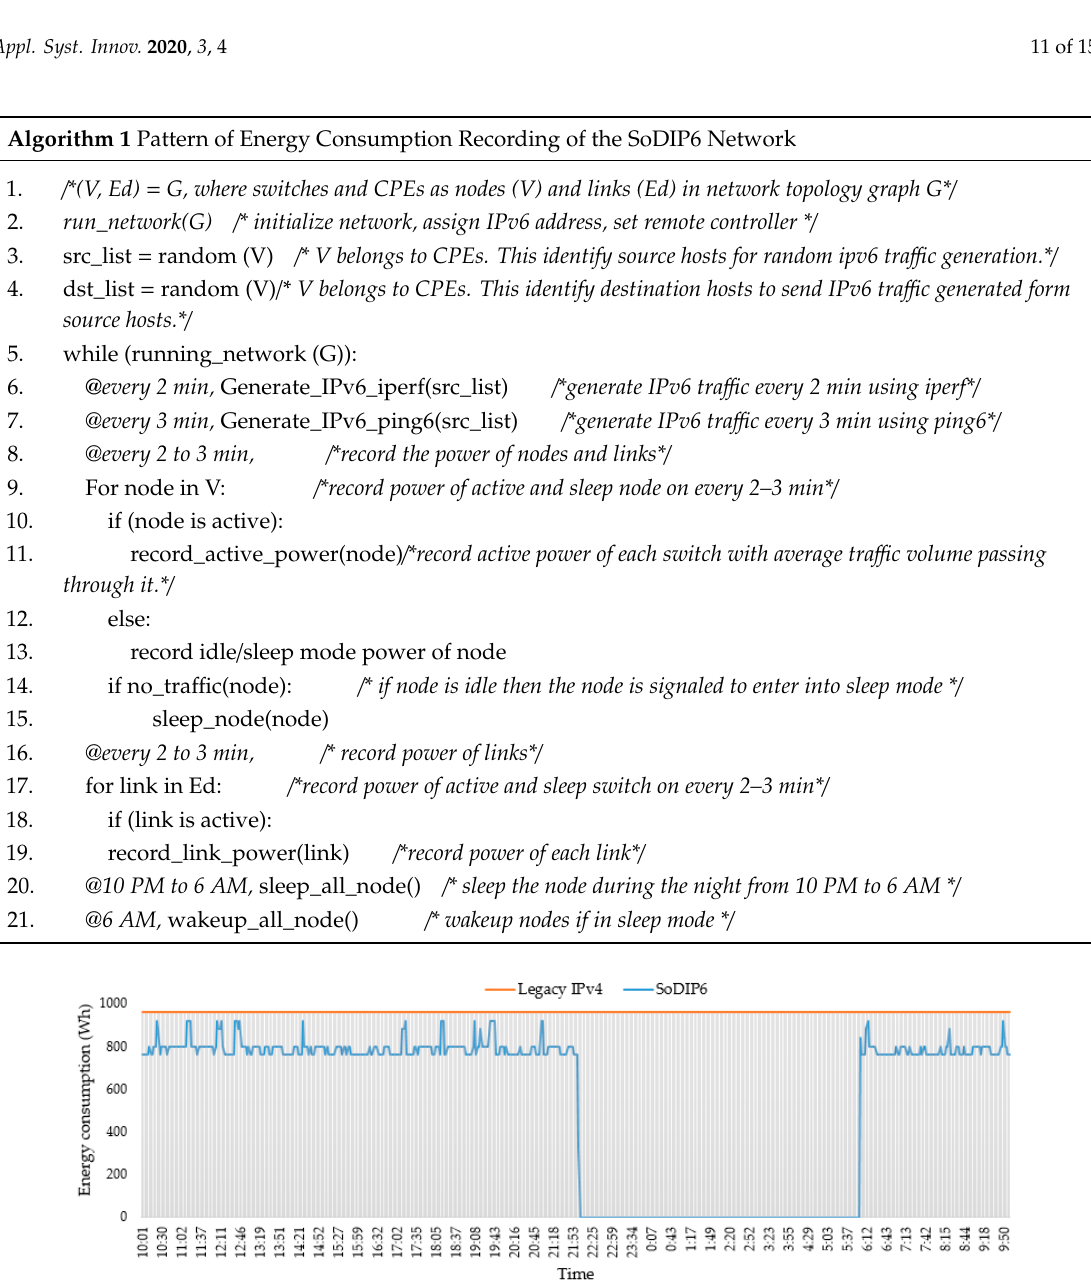
Figure 5. Pattern of total energy consumption by links in the legacy IPv4 and the SoDIP6 network.